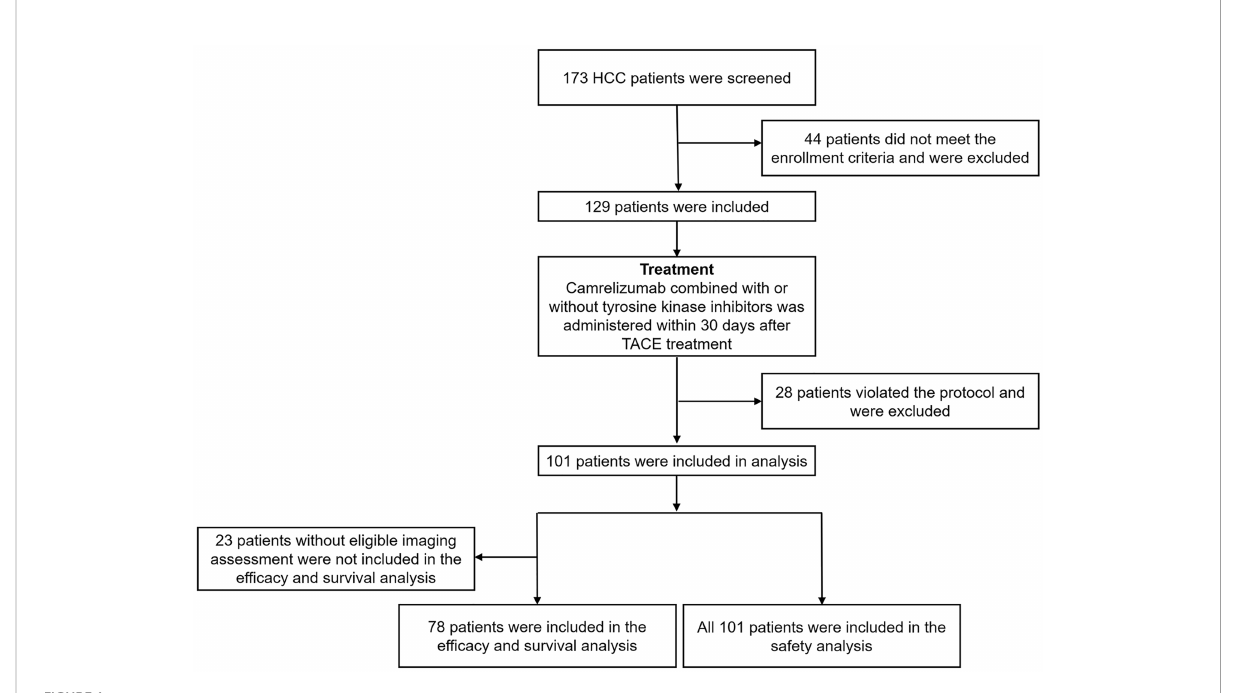
FIGURE 1 Study fl ow. HCC, hepatocellular carcinoma; TACE, transarterial